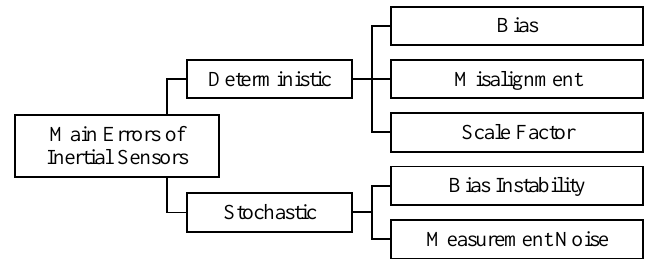
Figure 5. Main errors of inertial sensors.